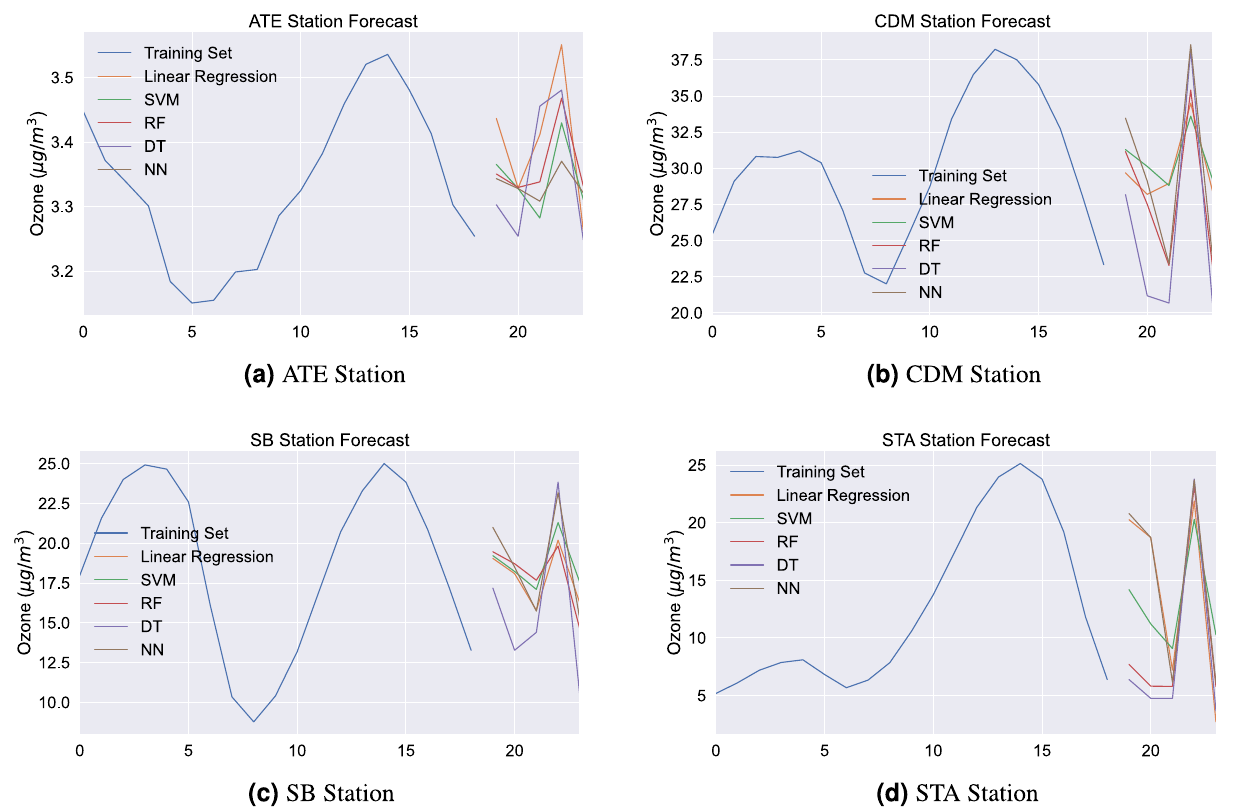
Figure 7. Forecast results plot. Observed data for ozone (training set) and forecast results for applied models: linear regression, support vector machine, random forest, decision tree, and neural